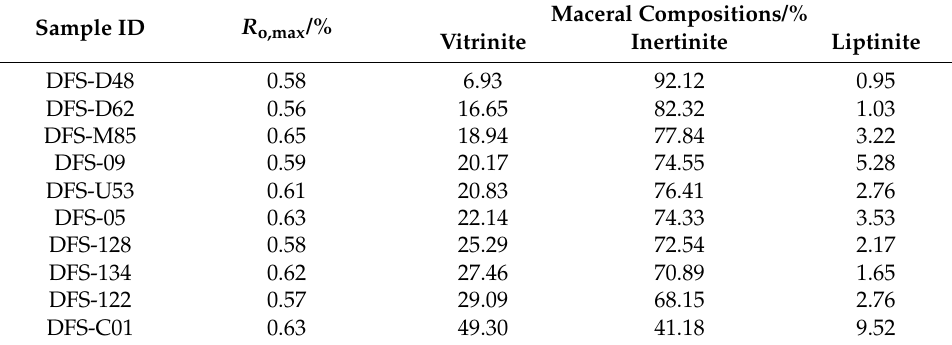
Table 3. Maceral of coal sample.